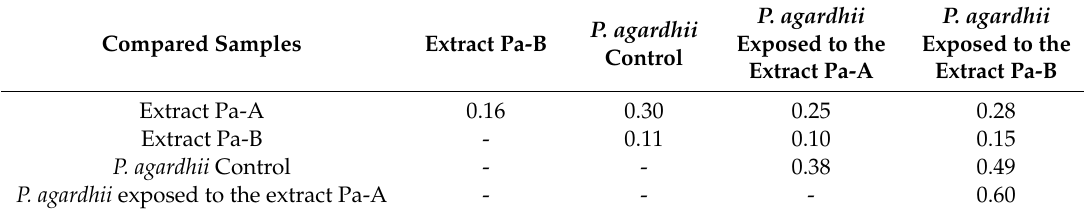
Table 3. The Jaccard index of similarity of the composition of oligopeptides found in the cyanobacterial extracts, control P. agardhii and P. agardhii exposed to the